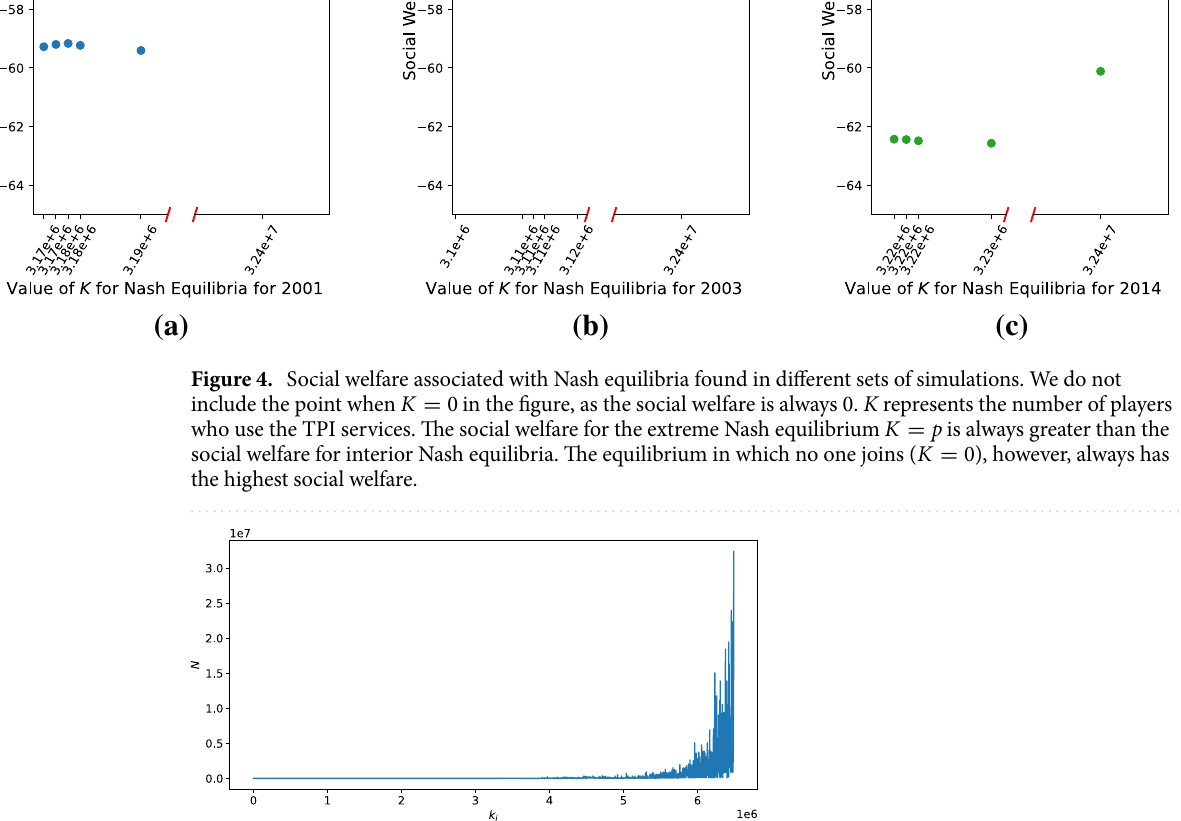
Figure 5. The number of players who choose to join the database ( N in Algorithm 1) as a function of k j . It can be seen that N fluctuates as k j increases. This occurs because players consider the utilities of their